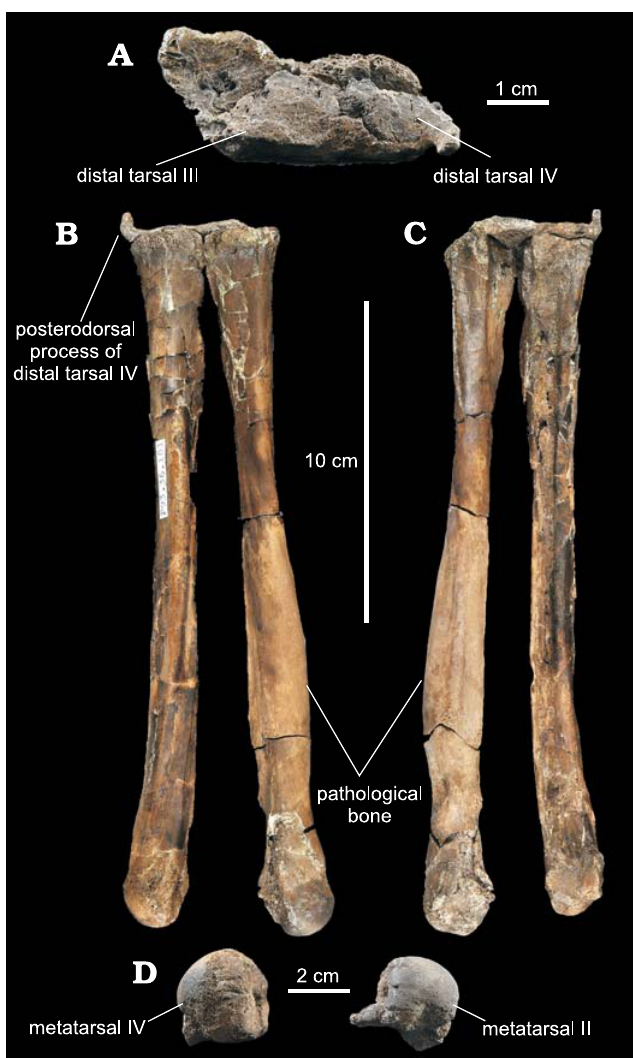
Fig. 6. Elmisaurine dinosaur Leptorhynchos elegans (Parks, 1933) (TMP 1993.036.0181) from the Upper Campanian Dinosaur Park Formation, Dinosaur Provincial Park, Alberta, Canada. Right tarsometatarsus in prox- imal ( A ), anterior ( B ), posterior ( C ), and distal ( D )